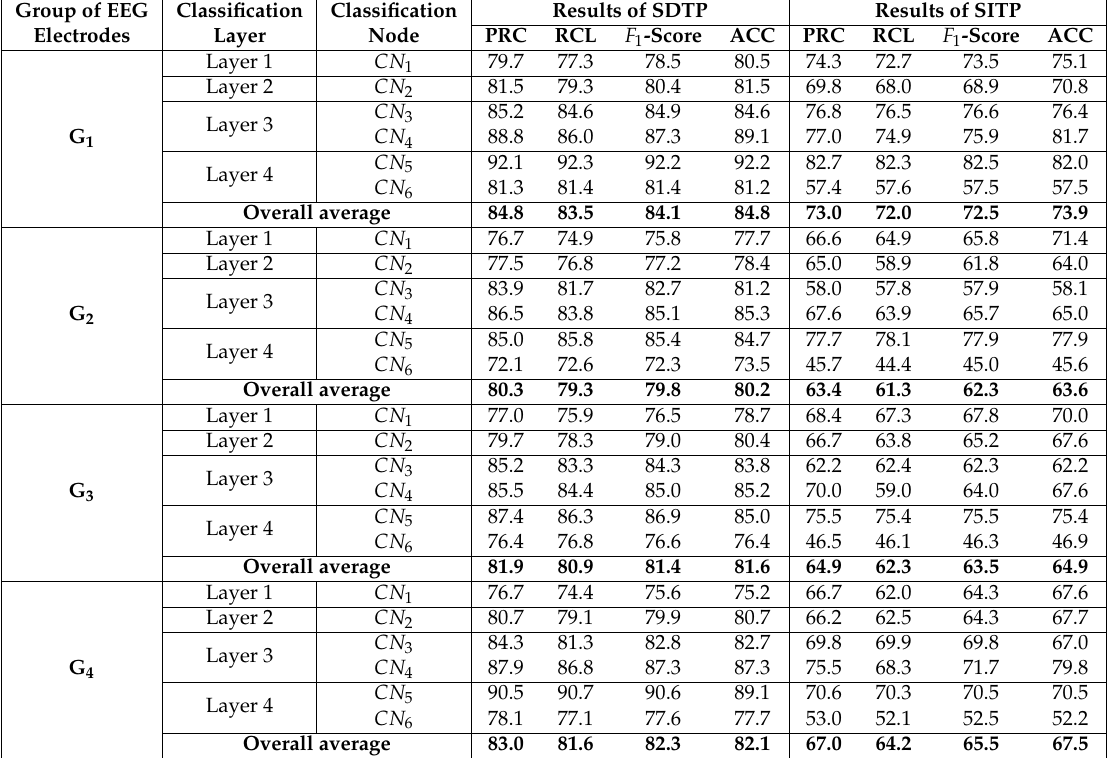
Table 5. Results of the channel-based analysis obtained using the SDTP and SITP for the amputated subjects in DB 2